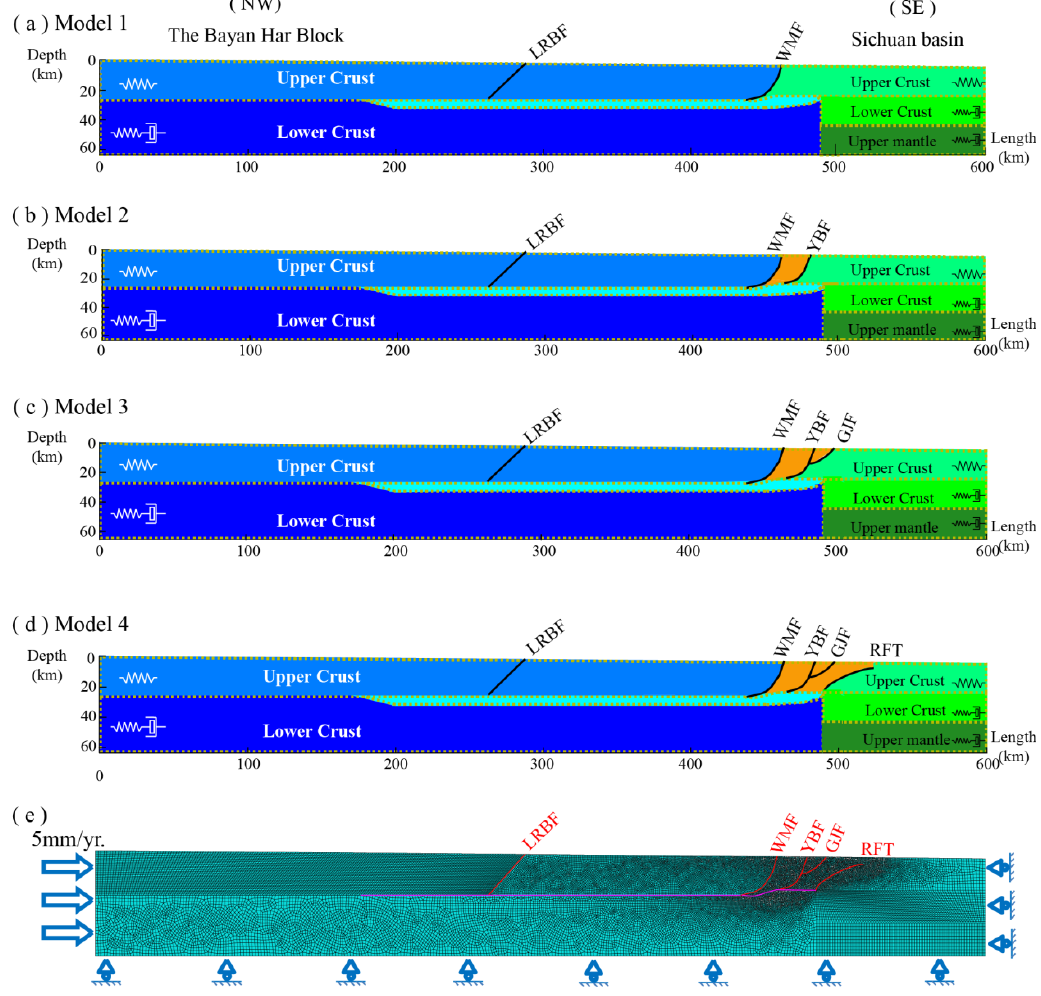
Figure 2. Design and parameter settings of the four fault models. ( a – d ) are the two - dimension models with different fault structures; Blue color: The Bayan Har block, including two layers, the upper crust and the lower crust; Cyan color: The detachment layer; Green color: The Sichuan basin, including three layers with nearly the same depth (about 20 km), the upper crust, the lower crust and the upper mantle; Orange color: The LMS; Thick black lines: Faults considered in the models. ( e ) result of mesh generation and boundary condition setting of Model 4; Red lines: Faults considered in the models; Magenta line: The upper contact surface of detachment layer.